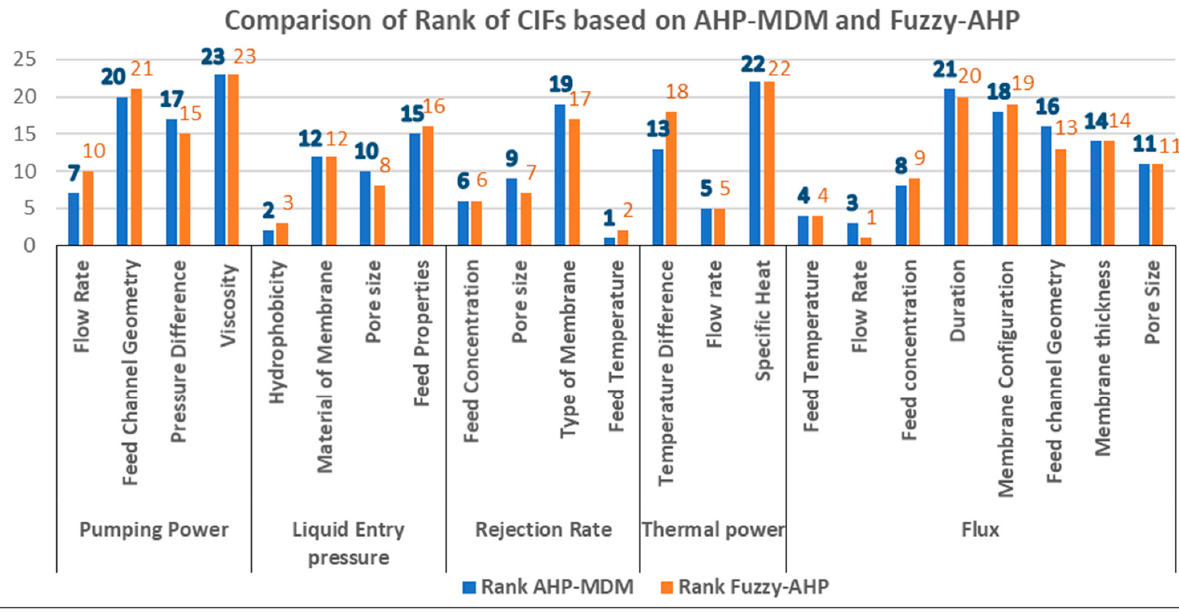
Figure 5. Comparison of ranks of CIFs of membrane distillation obtained using AHP-MDM and Fuzzy-AHP. Table 8. Composite weightages of CIFs of MD by using Fuzzy-AHP.